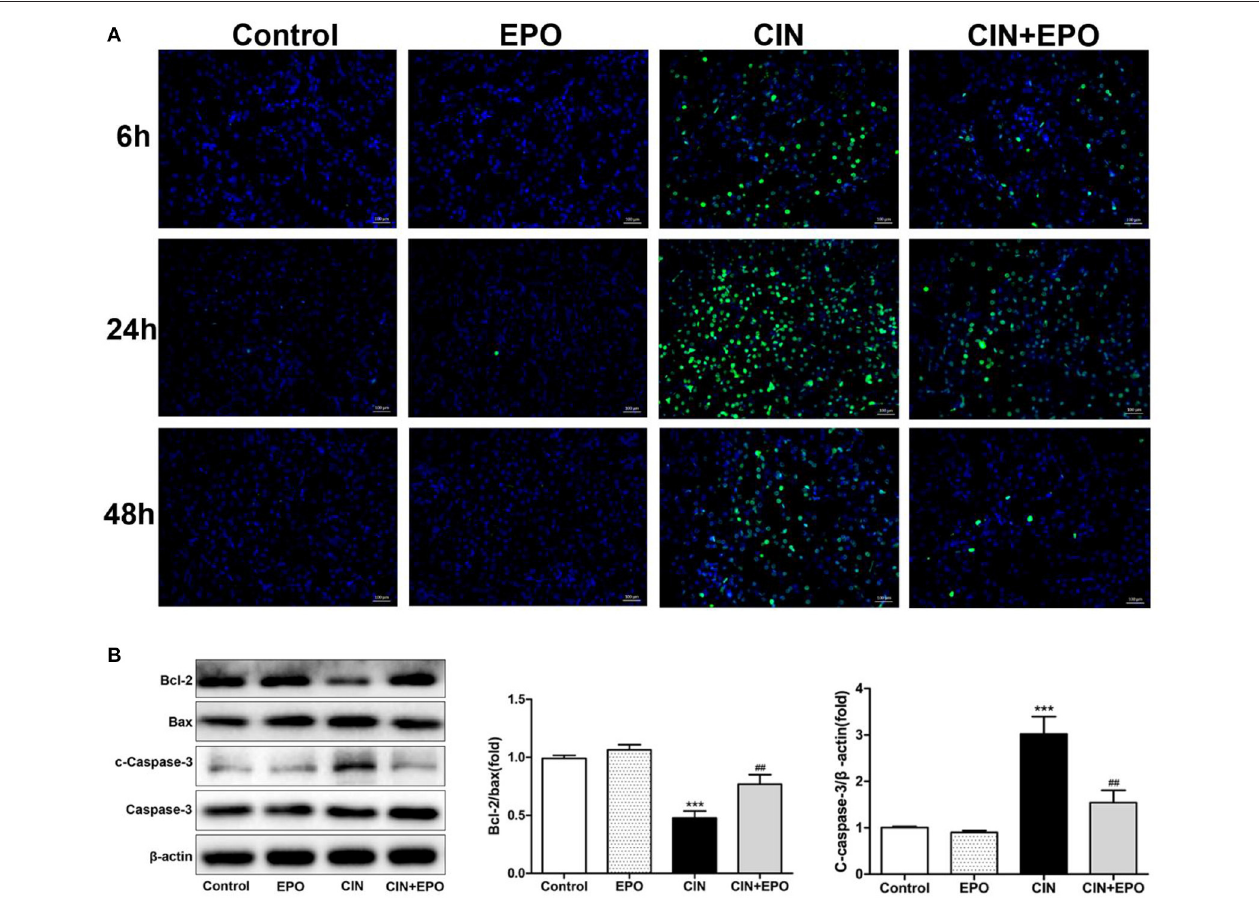
FIGURE 3 | Effect of EPO on apoptosis of renal tissue in CIN. (A) TUNEL staining was used to assess the kidney cell apoptosis in the presence and absence of EPO. Original magnification, × 400. (B) Apoptosis-related proteins, including Bax, cleaved caspase-3, and Bcl-2, were determined by Western blot assay. Each bar represents the mean ± SD calculated from three independent experiments. *** P < 0.001 vs. the control groups; ## P < 0.01 vs. the CIN groups. EPO, erythropoietin; CIN, contrast-induced nephrology; TUNEL, terminal deoxynucleotidyl transferase-mediated dUTP nick end labeling.